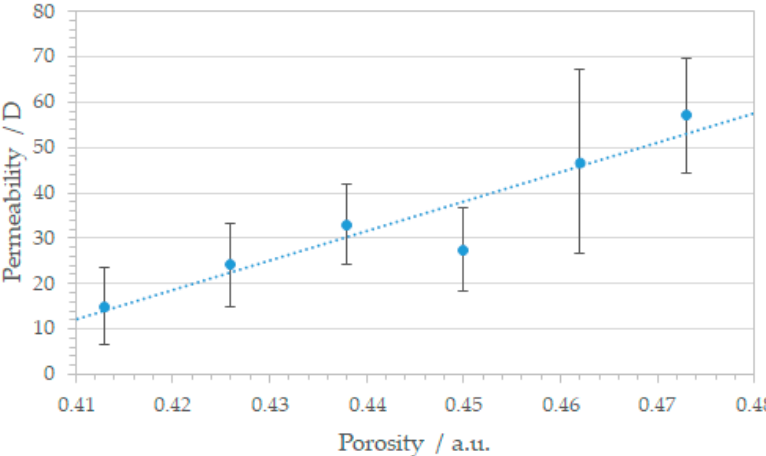
Figure 9. Correlation between permeability K and porosity of the honeycomb patterned SLM struc- tures. With increasing porosity permeability rises from less than 20D to nearly 60D.